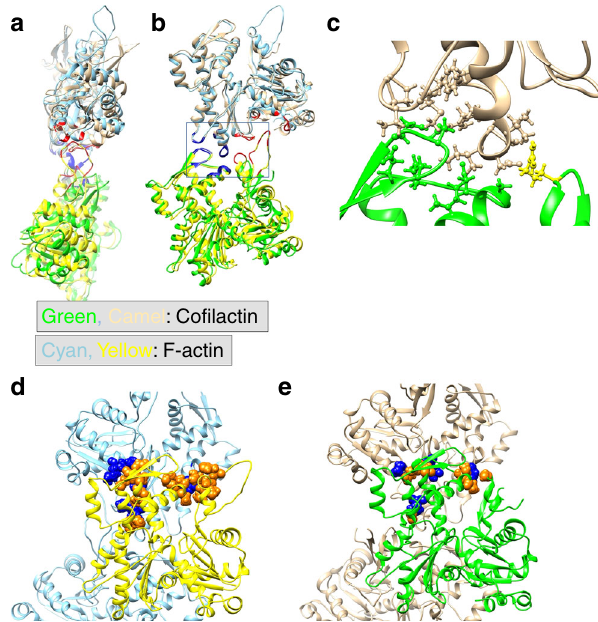
Fig. 3 Actin – actin interactions. The P-end is at the top. a Comparison of the intrastrand interactions between F-actin (5JLF, yellow and cyan) and co fi lactin (green and camel). The structures are aligned through superimposition of the IDs. The residues that are found in the interface of both F-actin and co fi lactin are colored blue, while those found solely in F- actin are colored red. b A 90° rotation of a . c An enlargement of the intrastrand interactions in co fi lactin in the rectangle in b . The side chains on the interface are shown as a ball and stick model. Arg62, the only residue of the outer domain contributing to the intrastrand interactions, is presented in yellow. d Interstrand interactions of F-actin. The interface residues, whose side chains form the interface, are shown as a space- fi lling model. The interface residues of the yellow subunit are shown in orange, and the other residues are shown in blue. e Interstrand interactions of co fi lactin. The interface residues in a space- fi lling model of the green subunit are shown in orange and the other residues are shown in